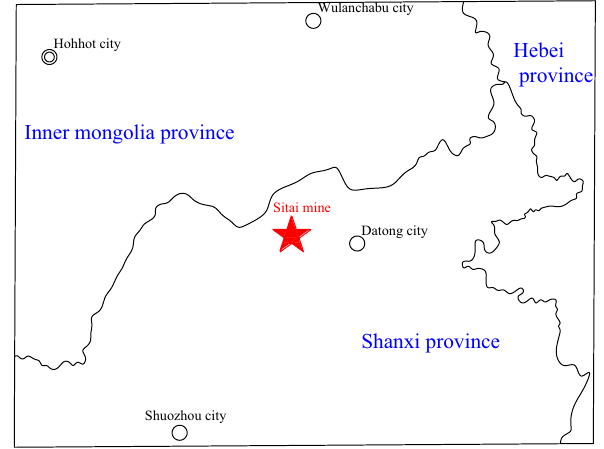
Figure 2. The location of the coal